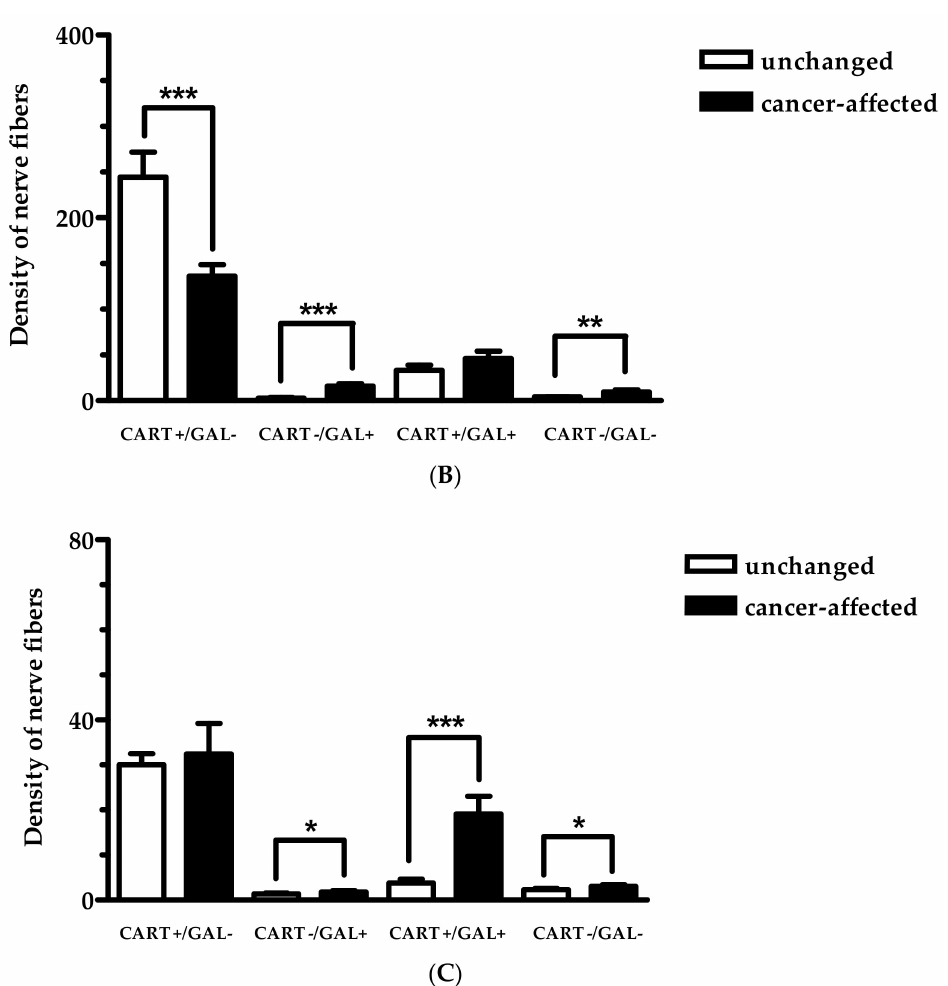
Figure 5. The mean density of nerve fibers containing CART and/or GAL in the longitudinal muscle layer (LML; ( A )), circular muscle layer (CML; ( B )) and lamina muscularis mucosae (LMM; ( C )) in both cancer-affected and control tissue from human stomach wall. Data were pooled and presented as the mean (range) of 10 patients. Data are presented as average number of nerve fibers ( ± SD) per area studied (900 µ m × 700 µ m); *, **, *** are p < 0.05, p < 0.01, and p < 0.001,